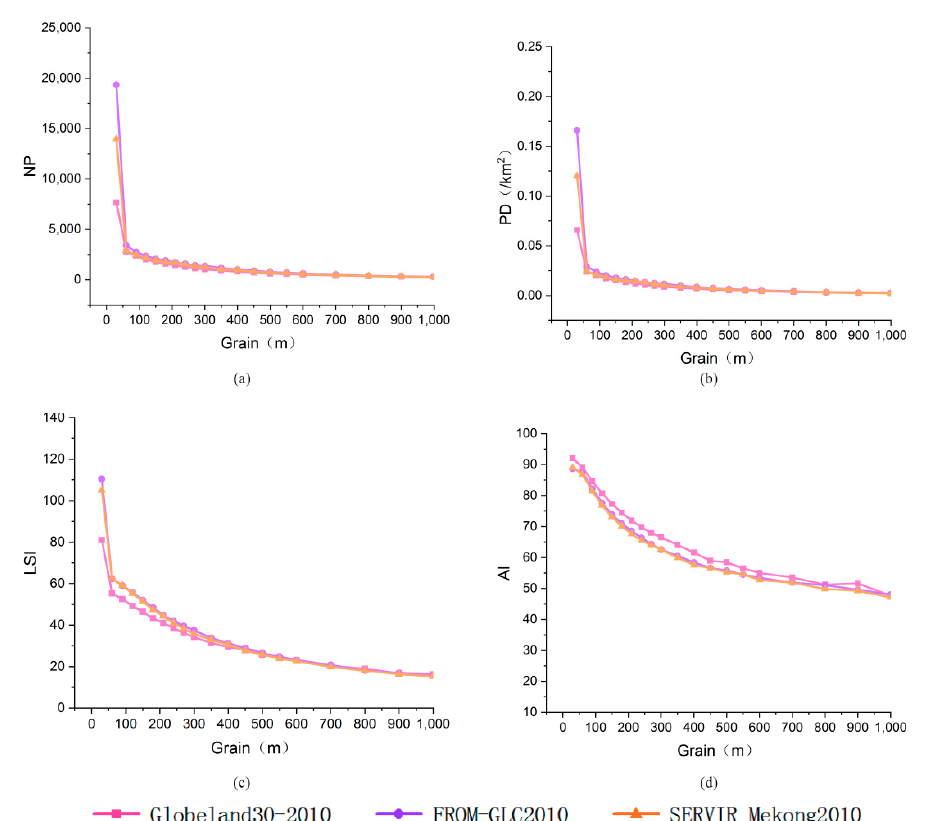
Figure 7. The water landscape pattern indices changing curves with scale increasing. ( a ) is the NP curve; ( b ) is the PD curve; ( c ) is the LSI curve; ( d ) is the AI curve. The e ff ects of scale on the NP, PD, and LSI indices of artificial surfaces were similar to those observed for cropland (Figure 8). The AI values of FROM-GLC2010 and SERVIR MEKONG2010 datasets increase sharply at a scale of 60 m, while the AI values decreased with slight fluctuations in other scale